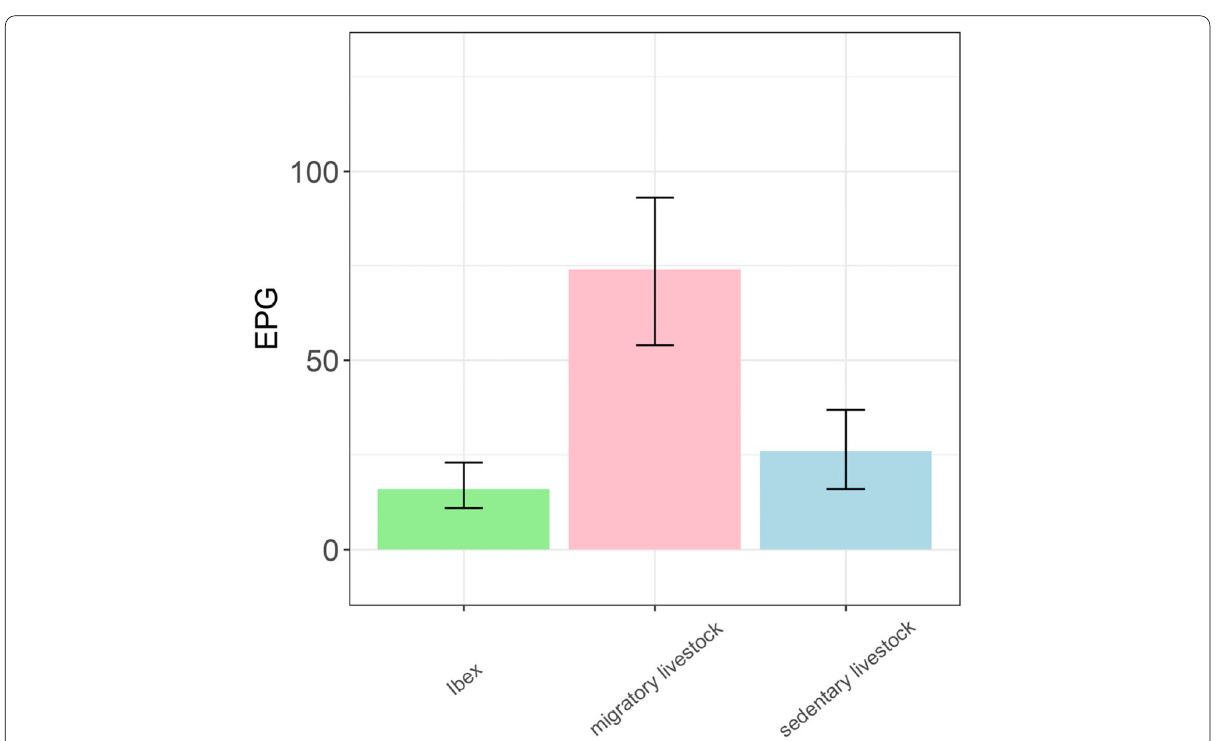
Fig. 4 Bar‑plot displaying bootstrapped mean cumulative faecal egg counts (eggs per gramme, EPG) for helminthic endo‑parasites across hosts. The bars display the 95% confidence intervals after bootstrapping the data. Sedentary